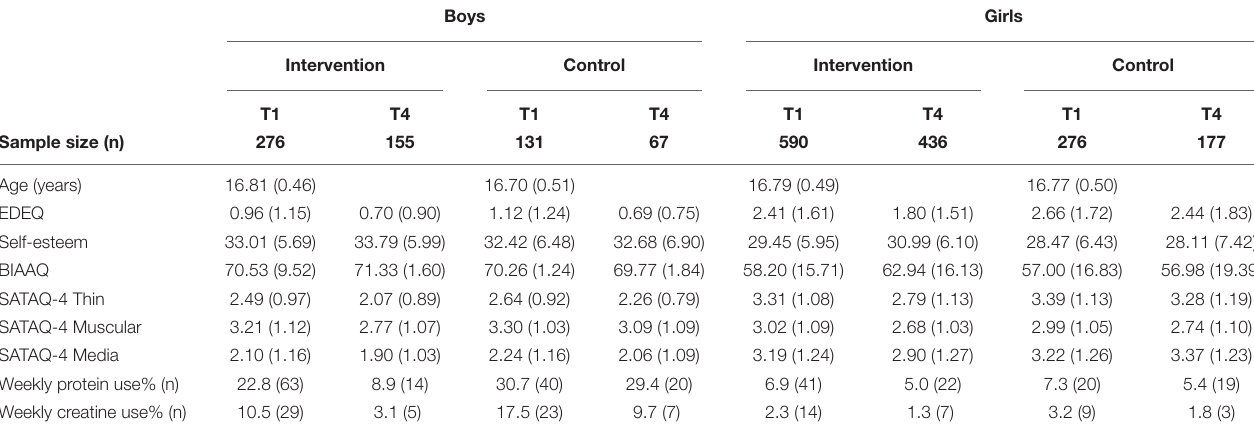
TABLE 2 | Sample characteristics shown as the mean and SD or percentage and number of observations (N). Boys